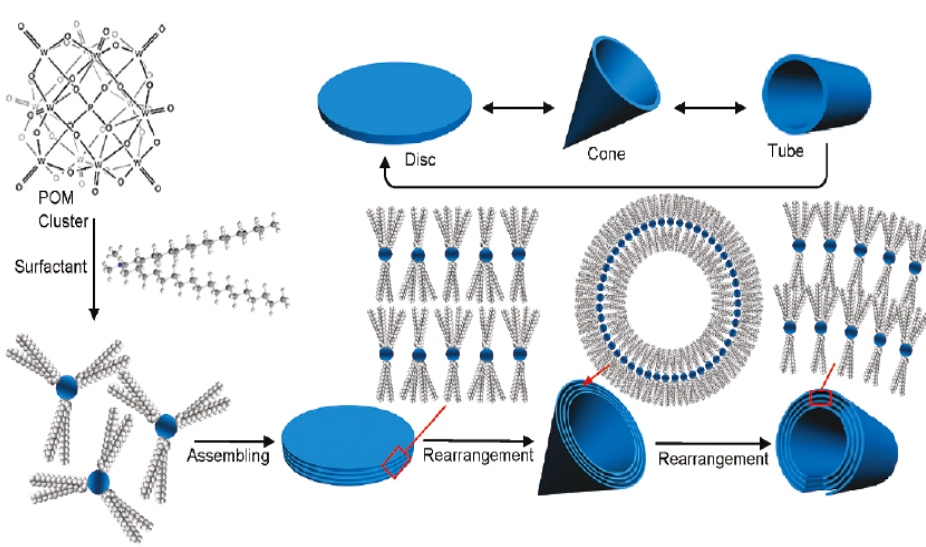
Fig. 12. Schematic illustration of three-dimensional arrangement of POM clusters in different nanostructures. Adapted from Ref [68].